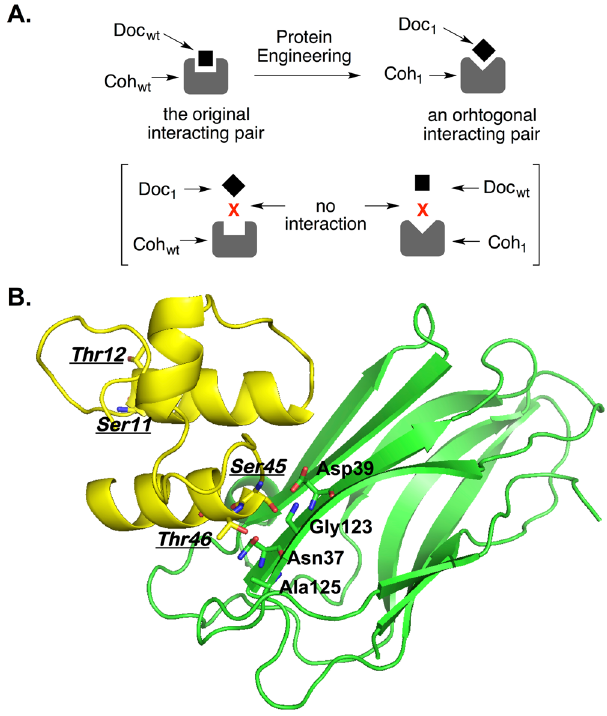
Figure 2. Generation of orthogonal protein pairs from a parent protein pair. ( A ) Generation of mutant dockerin-cohesin (Doc 1 -Coh 1 ) pair that is orthogonal to the parental Doc wt -Coh wt pair; ( B ) Structures of Doc wt - Coh wt pair from C. thermocellum . Residues from dockerin (yellow) are labeled in italic and underlined. Residues from cohesin (green) are labeled in regular